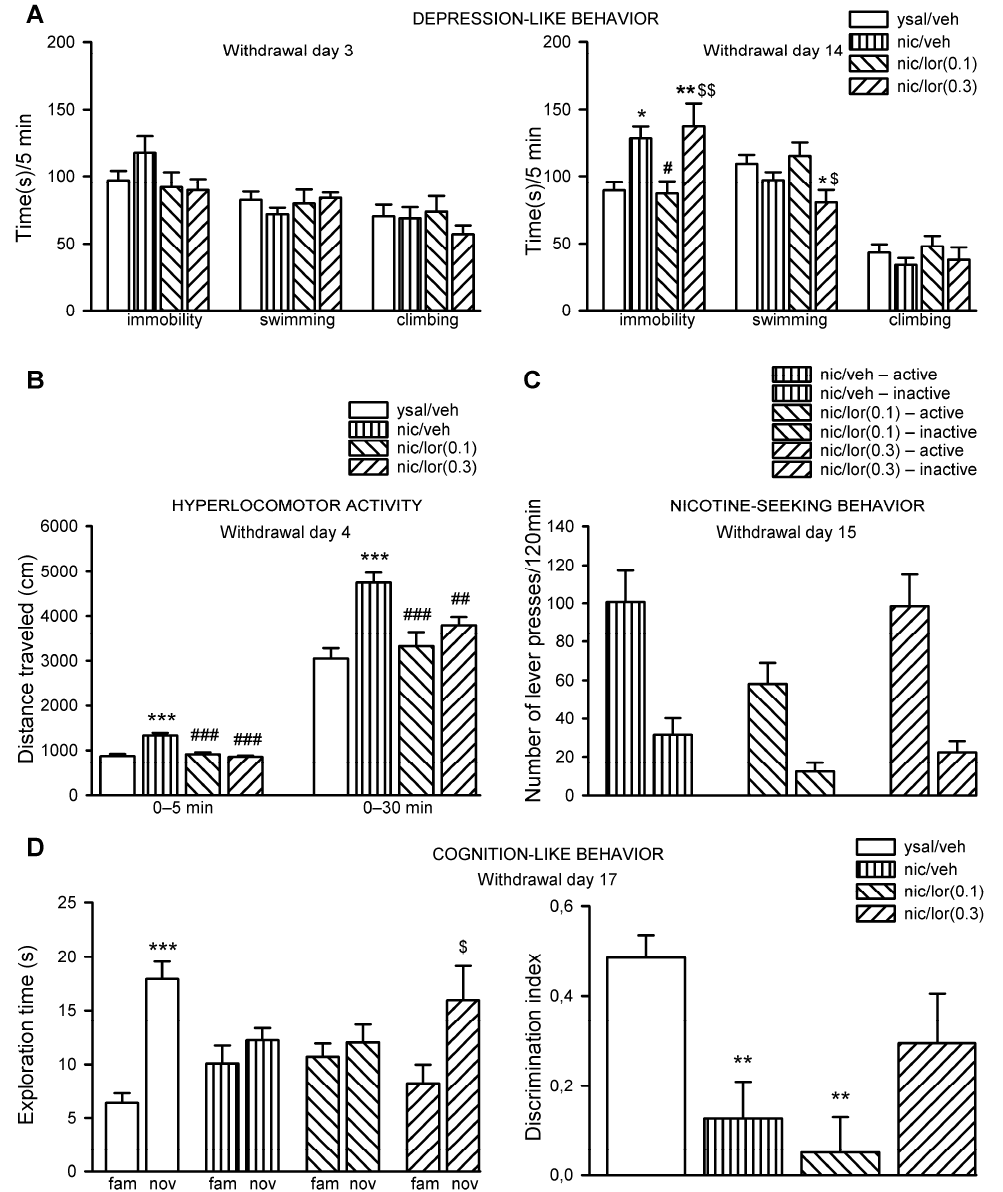
Figure 3. Effects of chronic lorcaserin administration on the behavioral signs of nicotine withdrawal. ( A ) Effects of chronic exposure to lorcaserin (0.1–0.3 mg/kg, lor(0.1)/(0.3)) during nicotine (nic) withdrawal on depression-like behavior in the forced swim test (FST) during early (day 3; left panel) and late (day 14; right panel) drug withdrawal. ( B ) Effects of chronic exposure to lor(0.1)/(0.3) on locomotor hyperactivity during drug withdrawal. ( C ) Effects of chronic exposure to lor(0.1)/(0.3) on lever presses induced by nic priming during abstinence. ( D ) Effects of chronic exposure to lor(0.1)/(0.3) on deficits in cognition-like behavior in the novel object recognition task (NORT) in nicotine-withdrawn rats. The data are expressed as the means (± SEM). ( A ) left panel: ysal/veh: n = 12; nic/veh: n = 11; nic/lor(0.1): n = 10; nic/lor(0.3): n = 8. Right panel: ysal/veh: n = 12; nic/veh: n = 11; nic/lor(0.1): n = 9; nic/lor(0.3): n = 9. ( B ) ysal/veh: n = 12; nic/veh: n = 11; nic/lor(0.1): n = 10; nic/lor(0.3): n = 9. ( C ) ysal/veh: n = 12; nic/veh: n = 10; nic/lor(0.1): n = 9; nic/lor(0.3): n = 9. ( D ) ysal/veh: n = 12; nic/veh: n = 11; nic/lor(0.1): n = 10; nic/lor(0.3): n = 9. ( A ) * p < 0.05, ** p < 0.01 versus ysal/veh; # p < 0.05 versus nic/veh; $ p < 0.05, $$ p < 0.01 versus nic/lor(0.1); ( B ) *** p < 0.001 versus ysal/veh; ## p < 0.01, ### p < 0.001 versus nic/veh; ( C ) Lever effect: p < 0.001 active-lever presses versus inactive-lever presses; lorcaserin effect: p < 0.05 nic/lor(0.1)–lever presses versus nic/veh or nic/lor(0.3); ( D ) left panel: *** p < 0.001 versus ysal/veh–familiar; $ p < 0.05 versus nic/lor(0.3)–familiar. Right panel: ** p < 0.01 versus ysal/veh.